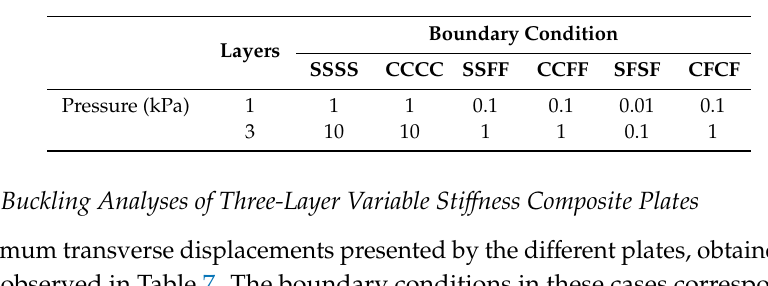
Table 6. Magnitudes of the uniformly distributed pressure.